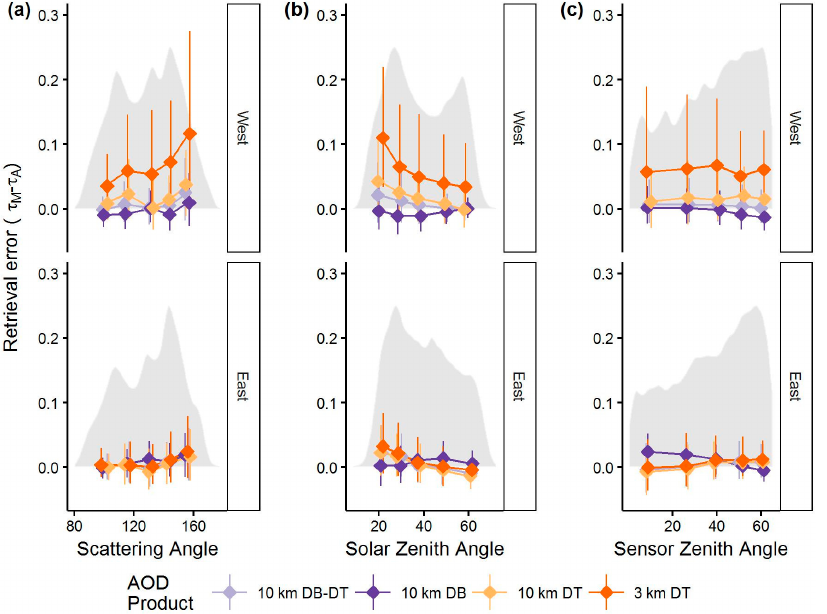
Figure 3. The dependence of AOD retrieval error and distributions of values for scattering angle ( a ); solar zenith angle ( b ); and sensor zenith angle ( c ). Median error (points) and the IQR (vertical line ranges from 25th to 75th percentile) is shown within quintiles. The distribution of values is shown in the background in gray and represents proportional frequency, where 0.25 on the y-axis represents the most frequent value in the category.